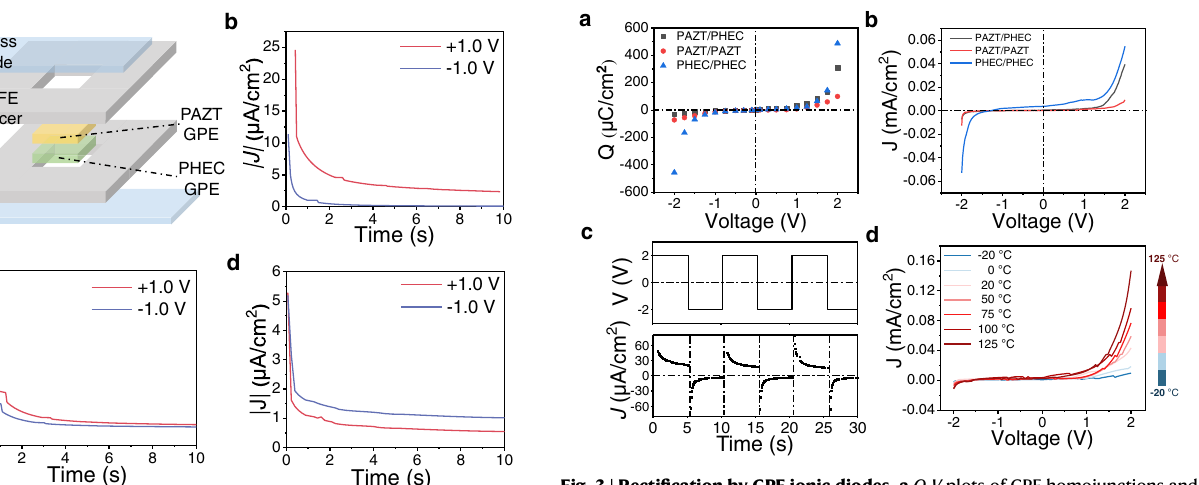
Fig. 3 | Recti fi cation by GPE ionic diodes. a Q - V plots of GPE homojunctions and heterojunction diode from − 2V to + 2V; b directly measured I – V curves for PHEC/ PHEC, PAZT/PAZT and PHEC/PAZT; c recti fi cation by the GPE ionic diode at alter- natingvoltageof±2Vat0.1Hz; d I – V curvesoftheGPEionicdiodeunderdifferent